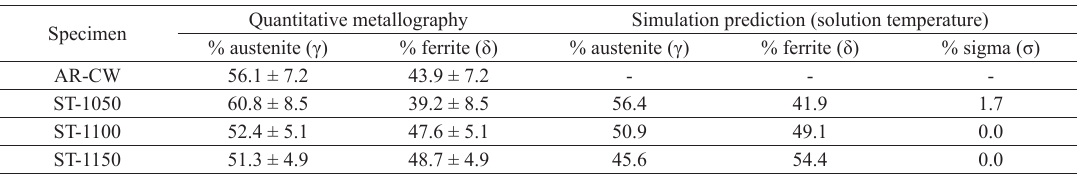
Table 3. Equilibrium contents (wt%) and PREN T( o C)